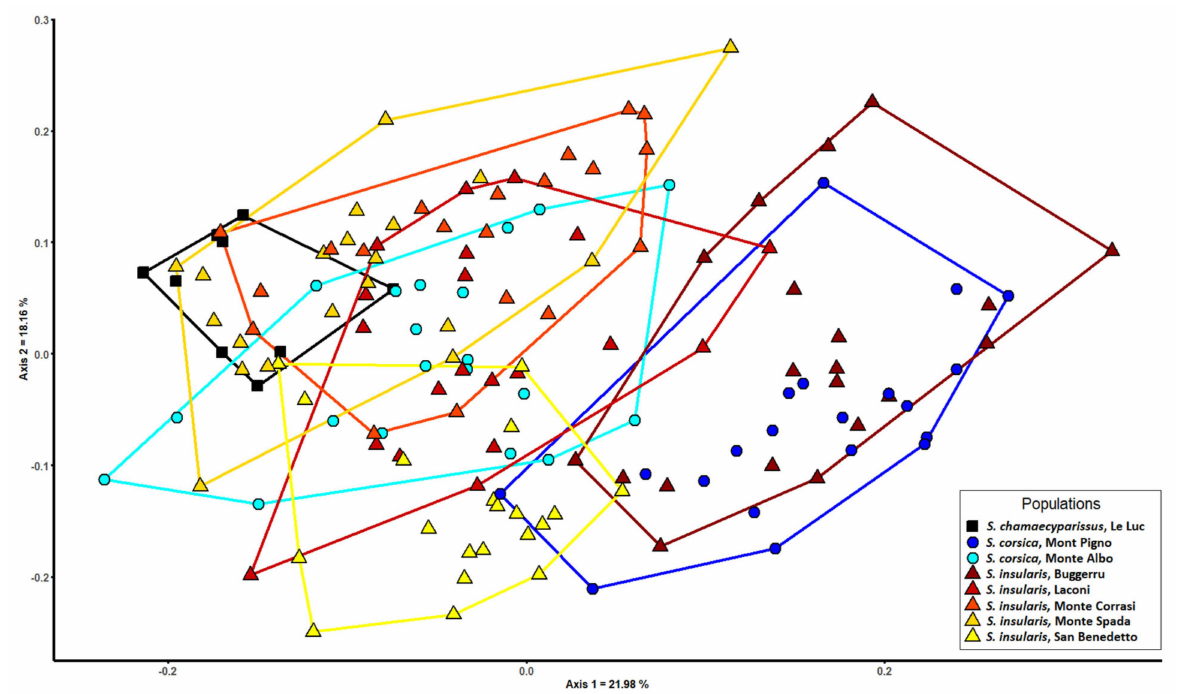
Figure 3. Morphometric analysis of Santolina chamaecyparissus , S. corsica , and S. insularis . Scatter plot of the first two axes of the PCoA based on Gower distance.